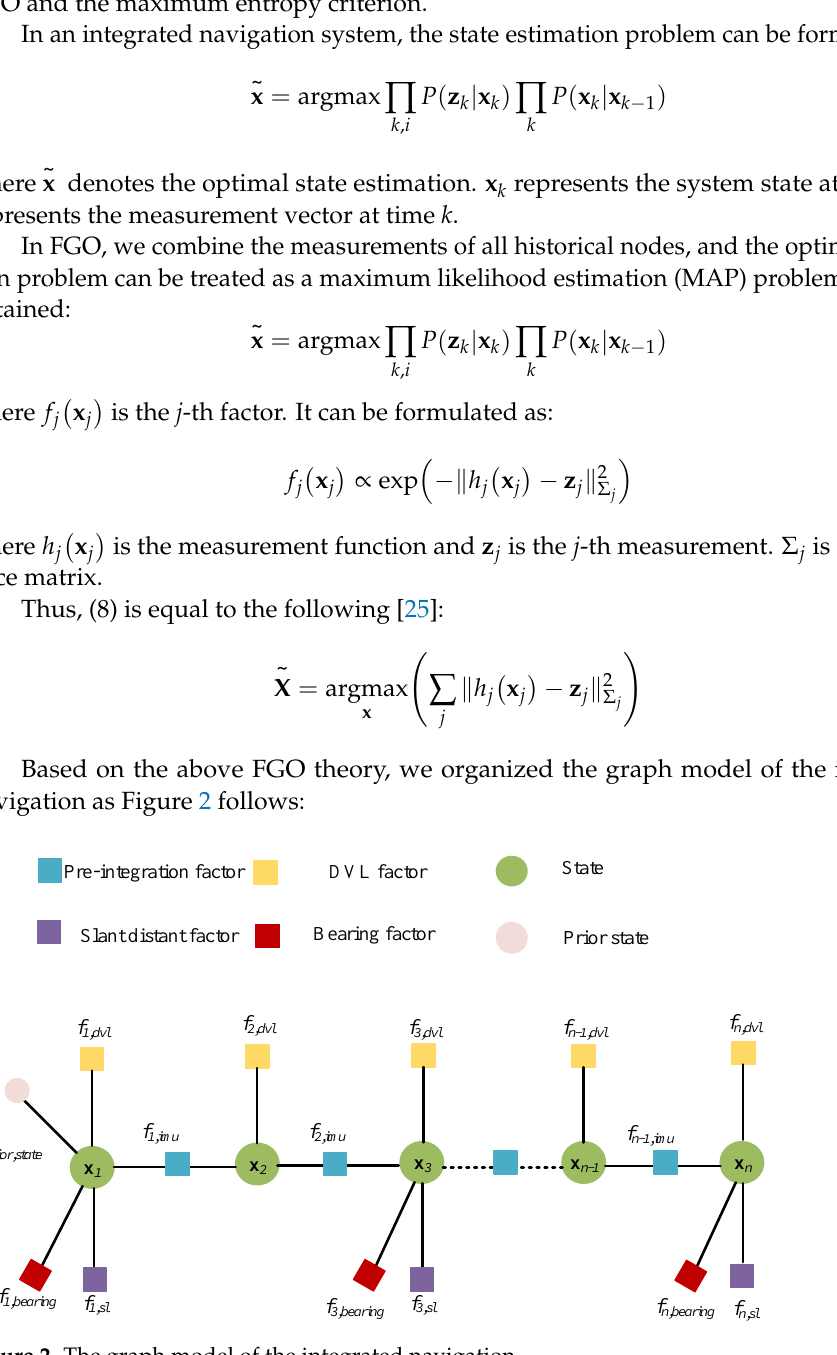
Figure 2. The graph model of the integrated navigation.